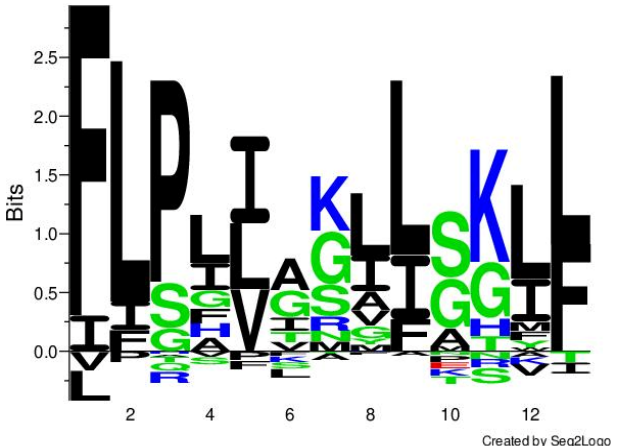
Figure 1. The sequence cluster of selected temporins from the DRAMP 2.0 database. The bits indicated the frequency of the presence of each amino acid residue in the position. The analysis was achieved by Seq2Logo online software. The black, green, blue, and red color represent hydrophobic, hydrophilic, basic, and acidic amino acid residues, respectively.